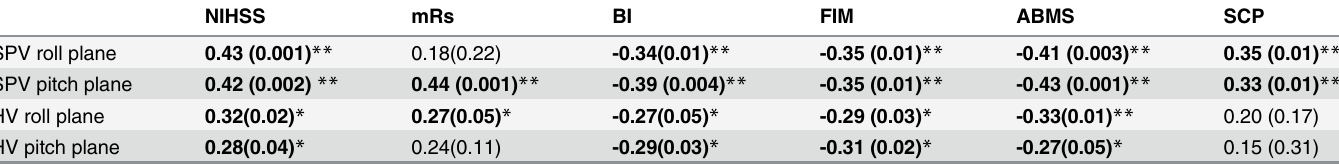
Table 6. Correlations between clinical and functional scales and SPV and HV in stroke